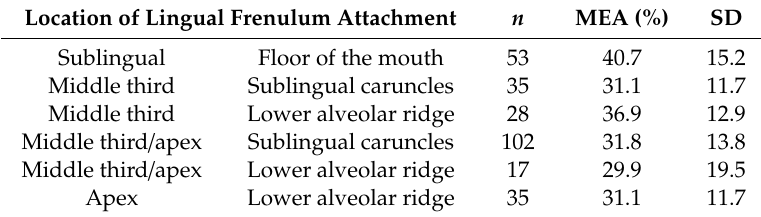
Table 2. Mean MEA of the suprahyoid muscles of infants based on the lingual frenulum attachment to the tongue and the floor of the mouth during